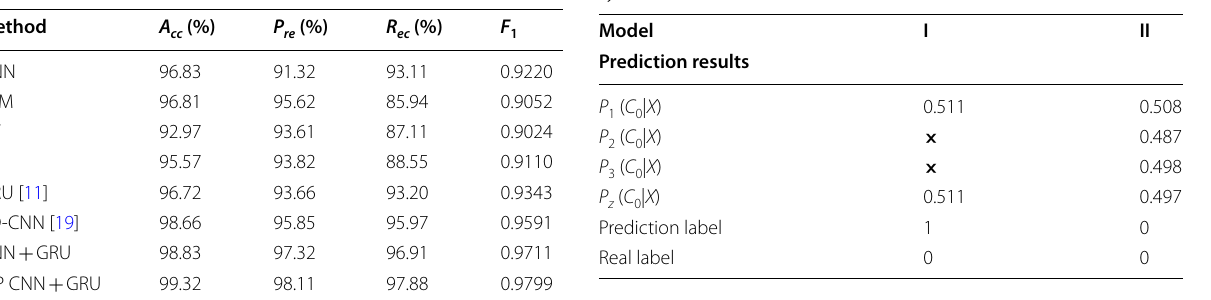
Table 3 TSA performance on the IEEE 145-bus system